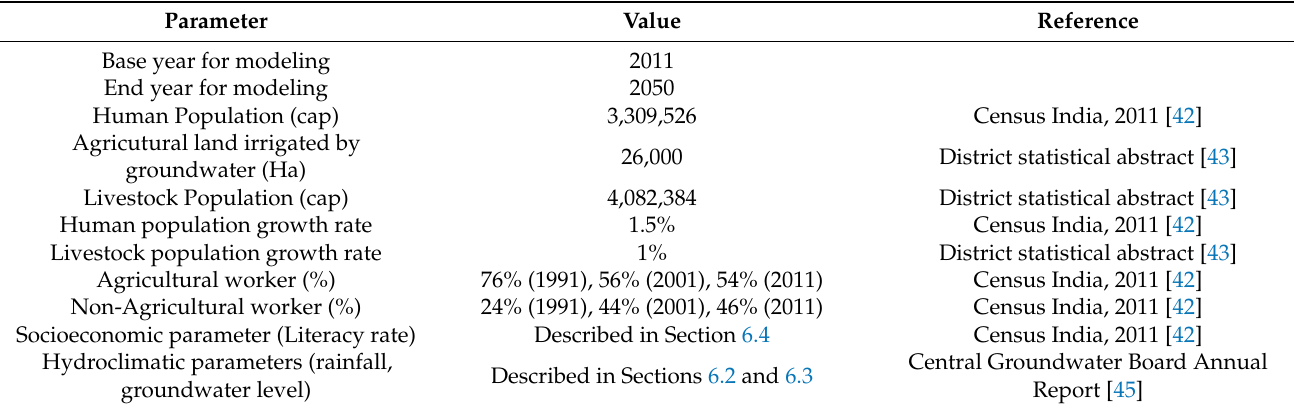
Table 1. List of parameters considered for this